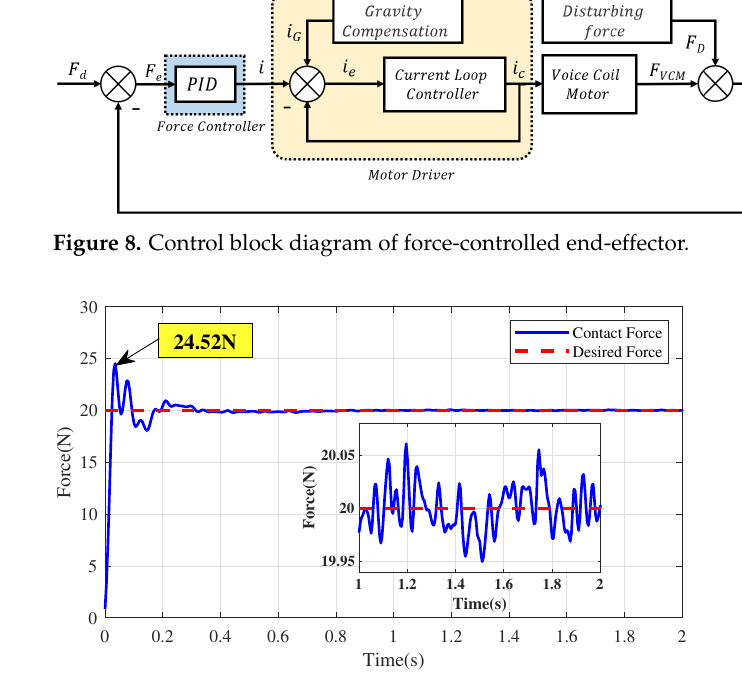
Figure 9. Force response of force-controlled